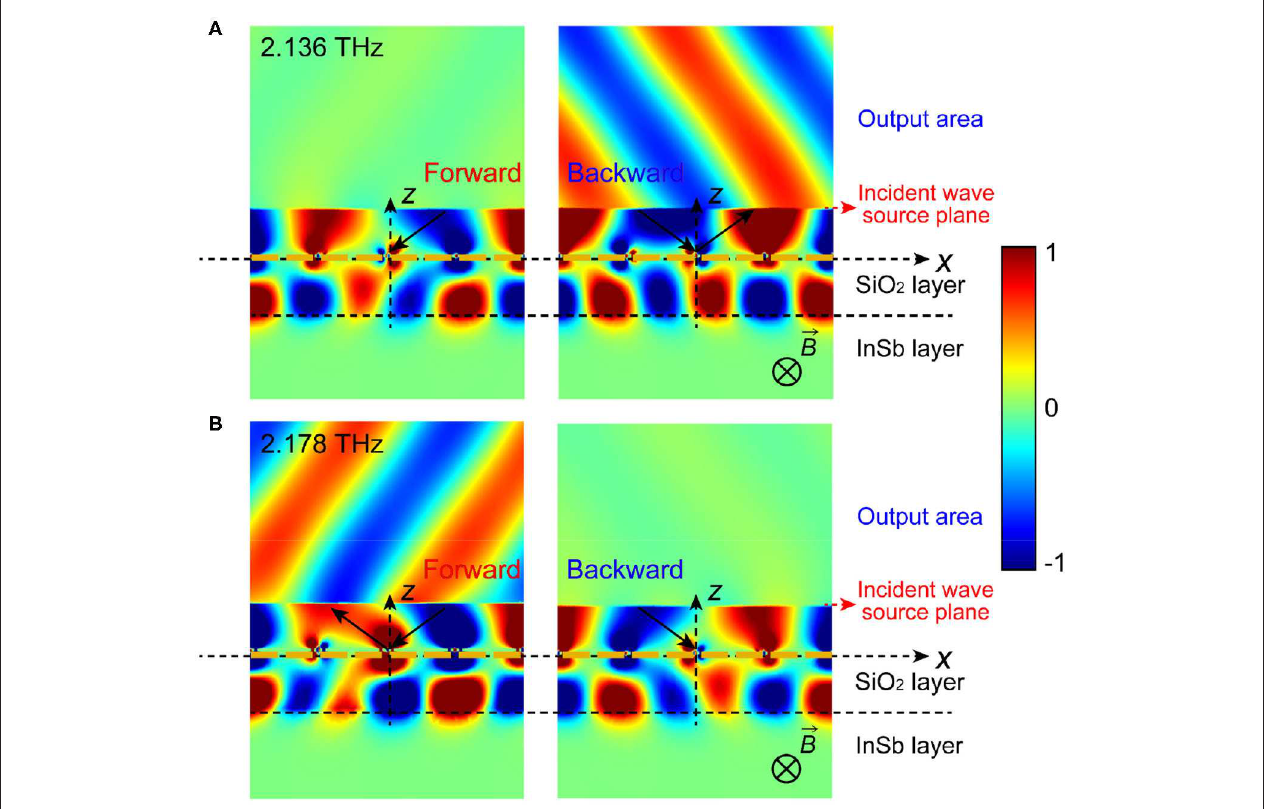
55 ◦ and B 0.2T at room temperature and the near field distribution of the E x = =